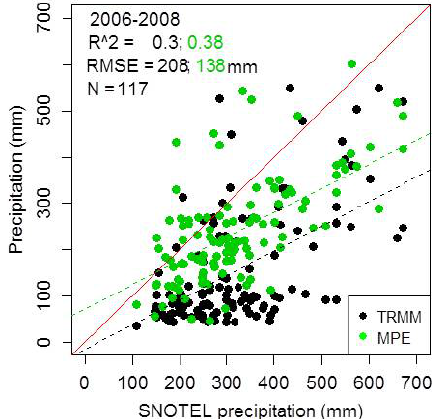
Fig. 2. Scatterplots of the total precipitation recorded at 39 SNO- TEL sites for the periods of 1 January 2006–30 April 2006, 1 Jan- uary 2007–30 April 2007, and 1 January 2008–28 April 2008 com- pared with precipitation estimates for the same locations from MPE (black) and TRMM